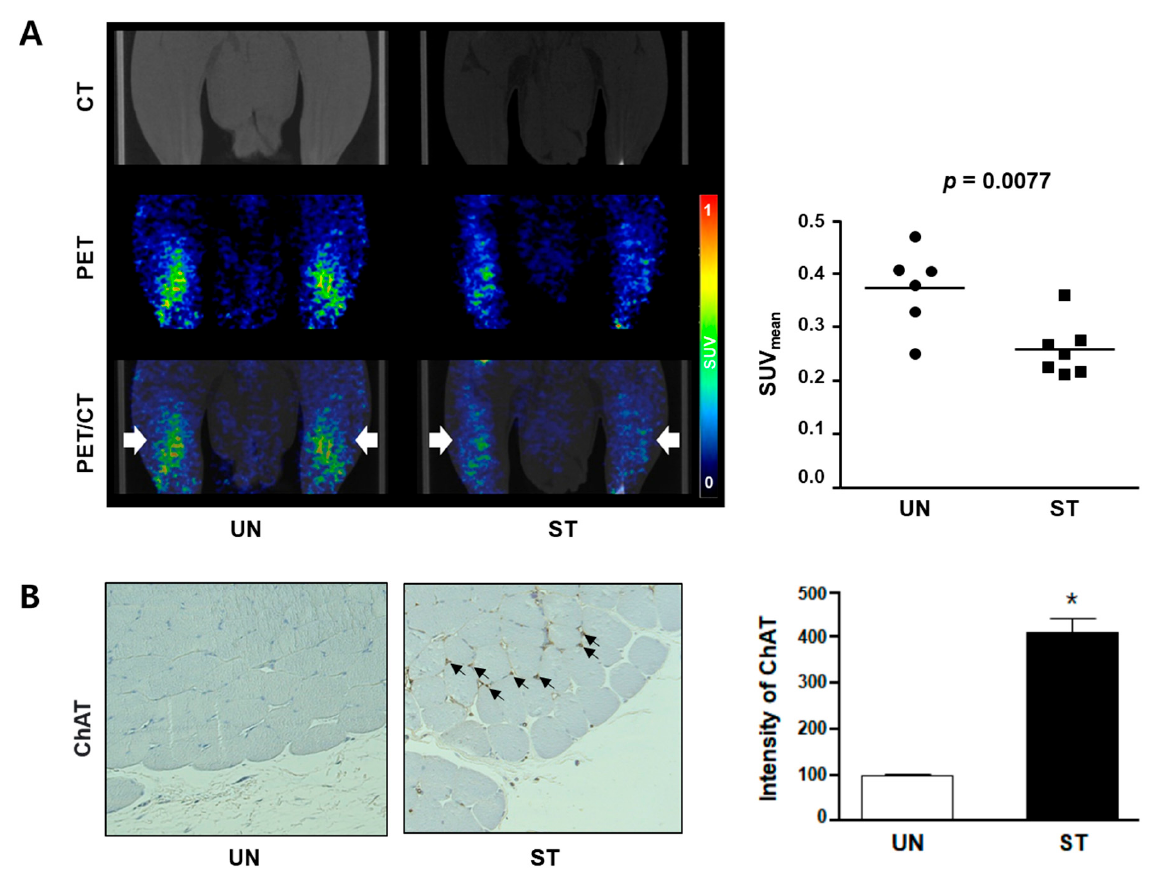
Figure 3. 18 F-Fluorocholine ( 18 F-FCH) uptake and choline acetylase expression in skeletal muscle atrophic tissue in rats. ( A ) Choline uptake in the atrophic skeletal muscle was determined using CT and PET with 18 F-FCH tracer. The volume of interest (VOI; white arrows) indicates both legs (hindlimb). The graph indicates SUV mean in VOI in the UN ( n = 6) and ST groups ( n = 7). ( B ) ChAT expression level in gastrocnemius tissue was determined using immunohistochemical staining ( n = 3). The brown color indicates the positive expression of ChAT (black arrows). The bar graph indicates the relative expression of ChAT. The expression level of ChAT in the UN group is considered 100%. * p < 0.05 vs. the UN group. CT, computed tomography; PET, positron emission tomography; ChAT, choline acetyltransferase; SUV mean , standardized uptake value mean; UN, untreated; ST, starved.